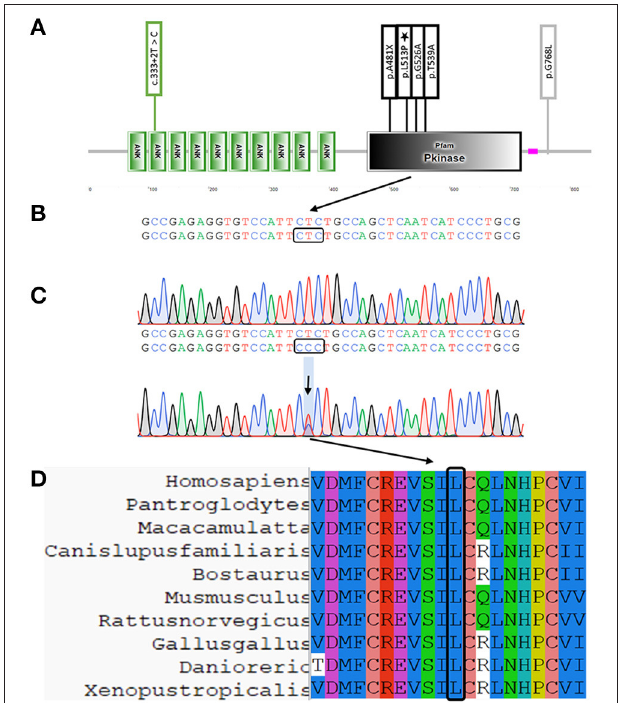
FIGURE 2 | Location and conservation of TNNI3K L513P variant. (A) Schematic diagram of TNNI3K protein structure and variants’ location. Asterisks represent a variant identified in this study (B) The protein topology is shown for TNNI3K , including 10 functional ankyrin repeat domains, a serine-rich domain (purple), and a single functional kinase domain where the heterozygous c.1538 T > C resides (black). (C) Sanger sequencing verified the variant. (D) Conservation of this residue.